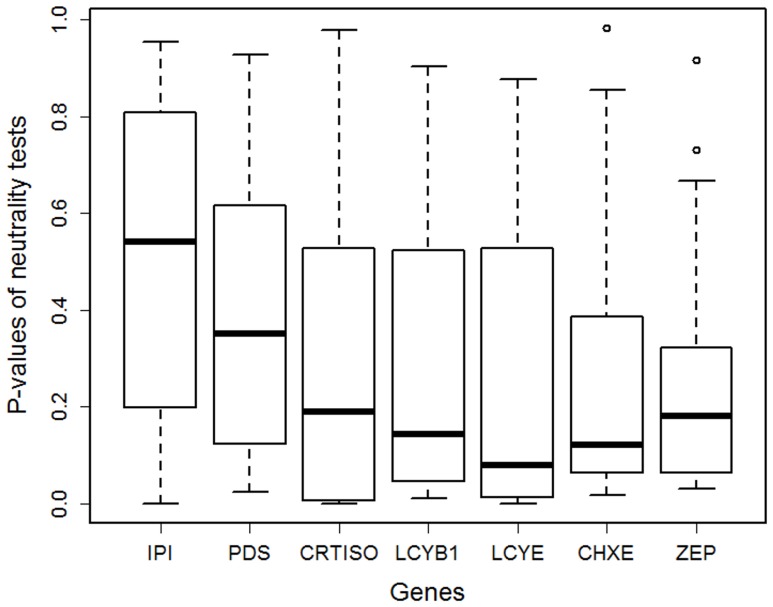
Selection in carotenoid biosynthesis pathway in carrot as a function of gene position.Distribution of p-values obtained according the rank of Tajima’s D, normalized Fay and Wu’s H and FST for the seven carotenoid biosynthesis genes in carrot by comparison with the expected distribution obtained by approximate Bayesian computation simulations under the divergence model. Each boxplot combines p-values obtained on pooled, geographic and color samples. The genes are sorted according to their pathway position.